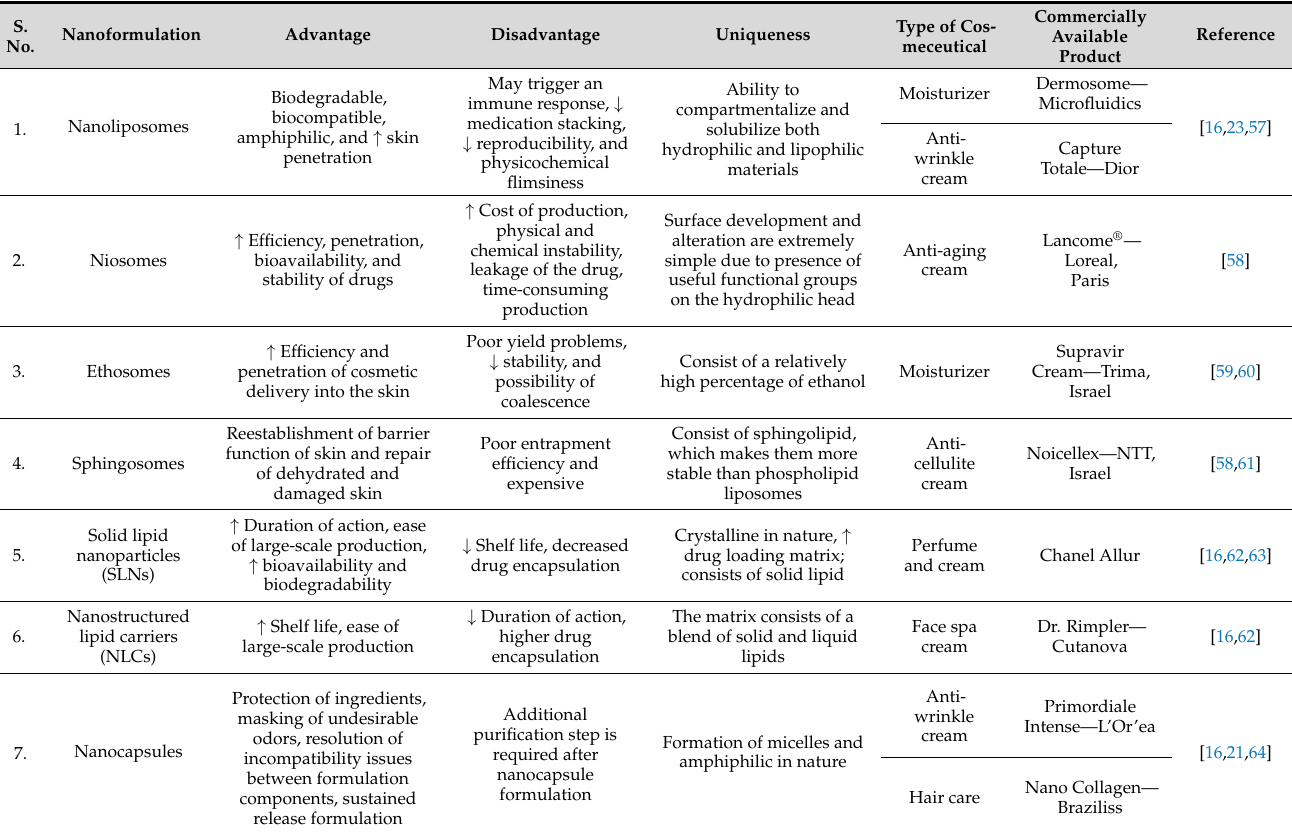
Figure 3. Various nanoformulations used in the cosmetic industry. Table 2. Nanoformulations used for preparing various